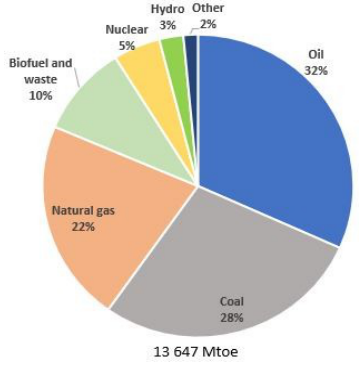
Figure 1. World energy matrix in 2015.